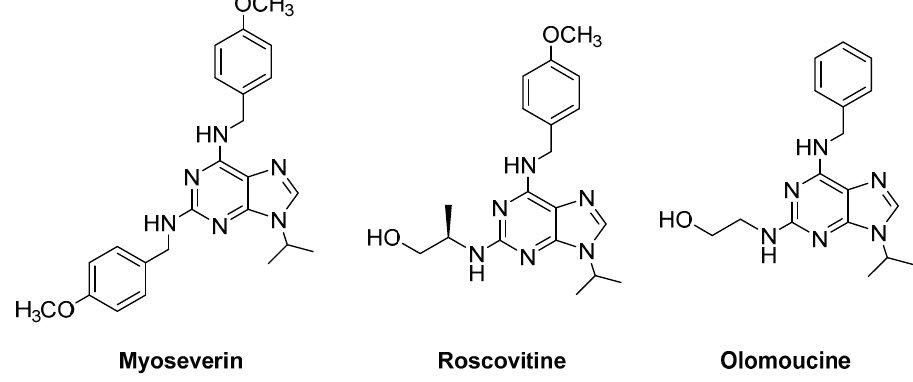
Figure 1. Chemical structures of 2,6,9-trisubstituted purines with biological